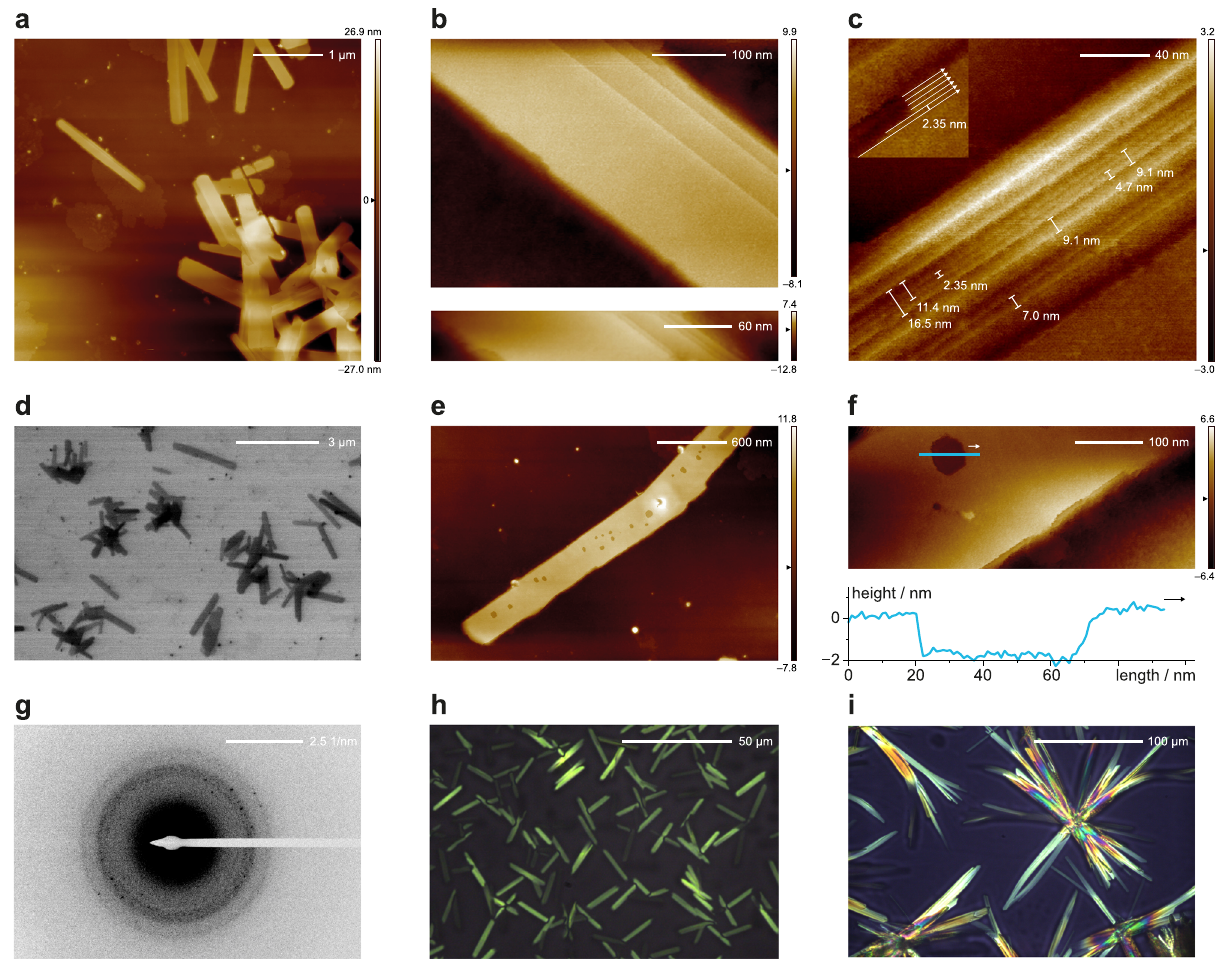
Fig. 3 Microscopy images of 2H-Car-C6 self-assembled into 2D sheets. a AFM images show sheets in contact with one another or isolated. b Sharp boundaries in multi-layer sheets allow distinction of individual units. c Individual columnar assemblies and their propagation direction can be distinguished in regions with defects, and by the step thickness of the edges (insert and Supplementary Fig. 50). d STEM image showing micrometer-long individual sheets and clusters. e and f AFM depth measurements of a hole indicate sheet thickness of 2 nm, consistent with that of a single molecule. g SAED pattern obtained from ensembles of 2D sheets. h and i POM images of bulk samples at different temperatures; 150°C heating ( h ) and 25 °C after slow (<5Kmin − 1 ) cooling from the isotropic melt ( i